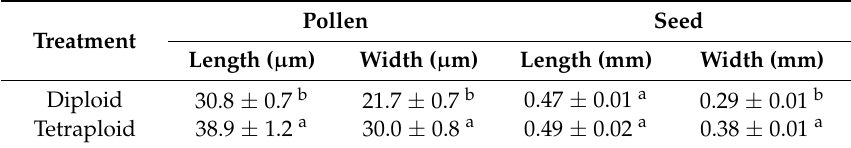
Table 5. Effect of polyploidy on size of pollens and seeds in Salvia miltiorrhiza.